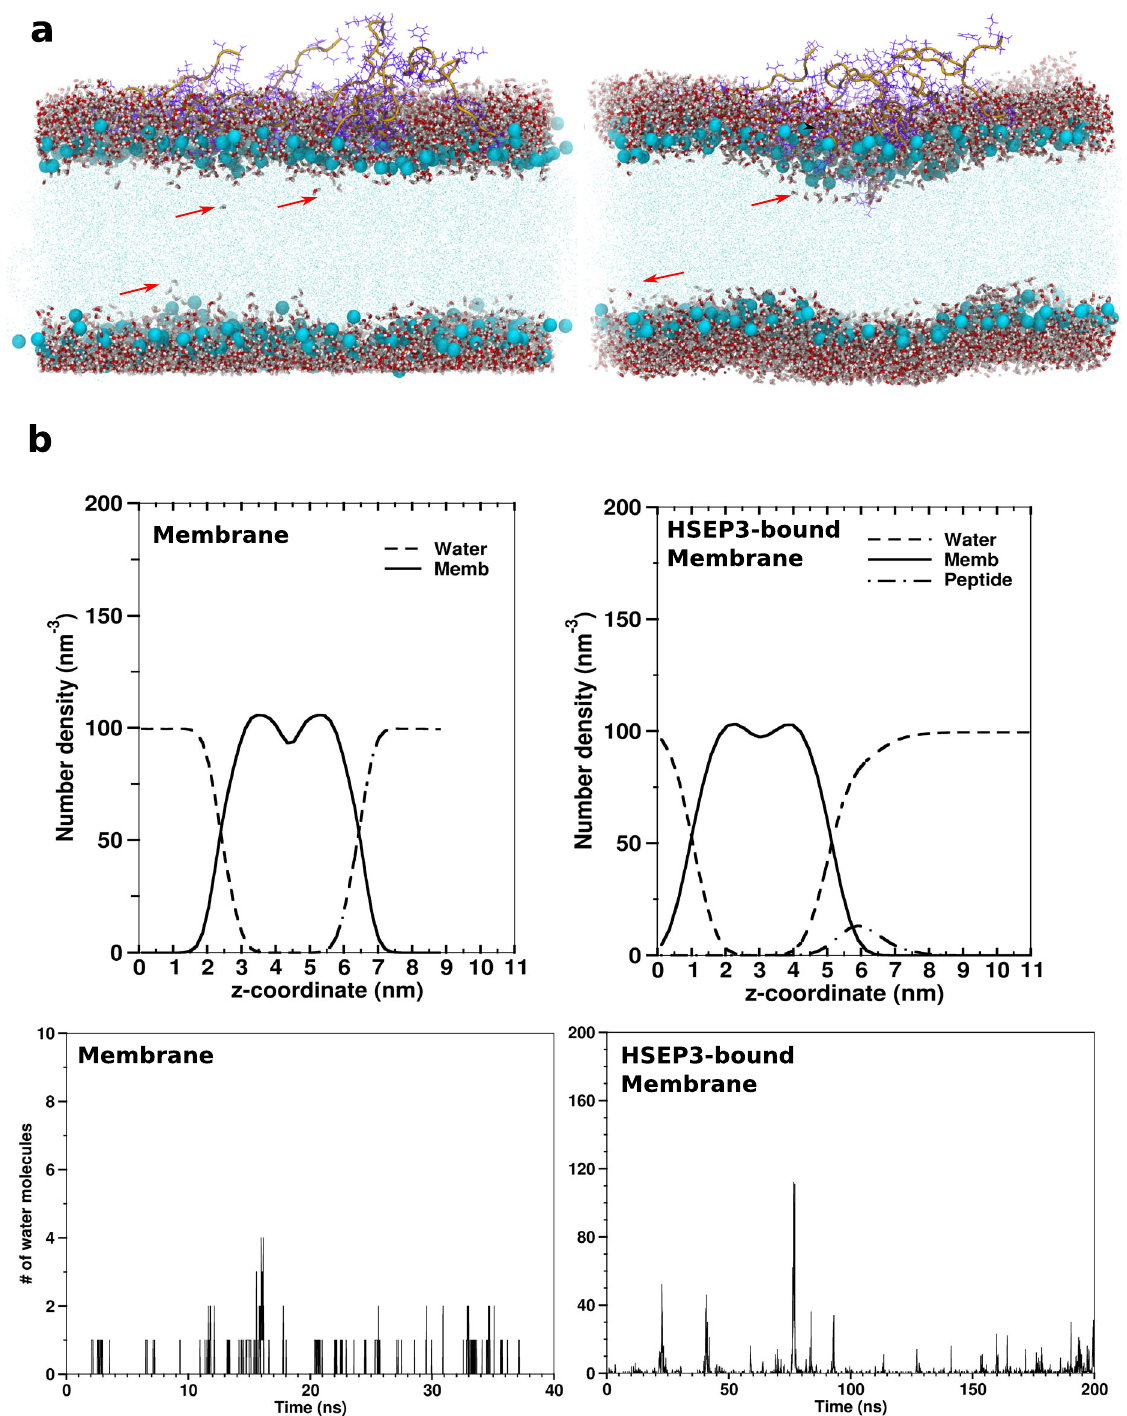
Fig. 8 Water permeability of HSEP3-bound membranes. a Trajectory snapshots showing water insertion defects in HSEP3-bound membranes. b Upper panels: Partial number density pro fi le for peptide-free and HSEP3-bound membrane simulations. Lower panels: Number of water molecules within hydrophobic region (the central 2.0 nm) of the bilayer per trajectory